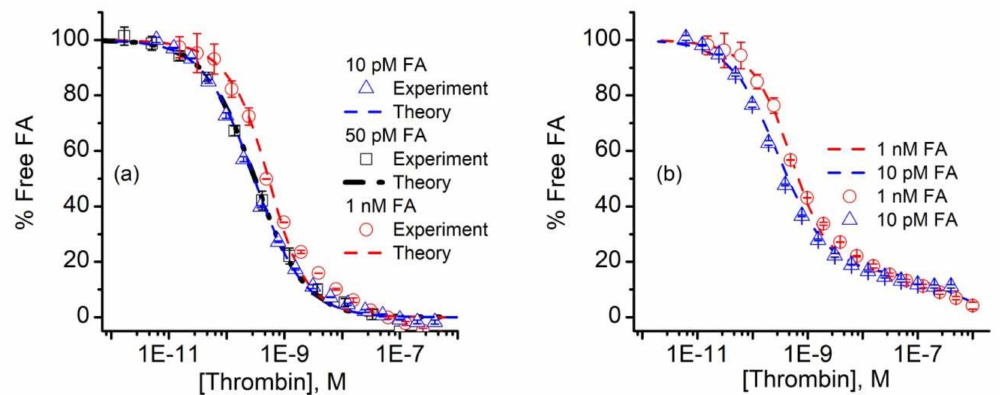
Figure 4. Analysis of FA binding data. ( a ) The n-curve analysis provided the calculated percent free FA (symbols) and theoretical simulations (dashed lines) for 10 pM, 50 pM, and 1 nM FA in the thrombin-titrated solutions for a 1:1 binding model. ( b ) The 10 pM and 1 nM FA signal data (symbols) were fitted with a binding model (dashed lines) that comprised a hypothetical mixture of two competing aptamers, characterized by di ff erent K d values. The experimental data represents average values ± SD (n = 3 for 50 pM FA, and n = 2 for 10 pM and 1 nM